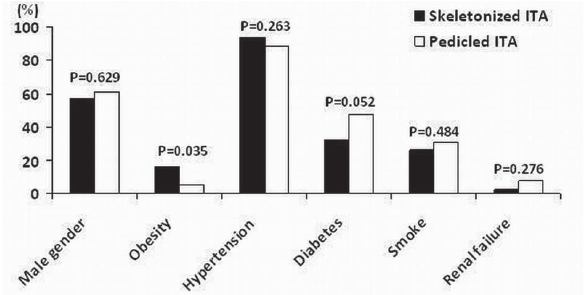
Fig. 1 – Description of preoperative clinical characteristics in elderly undergoing CABG. ITA = internal thoracic artery; CABG